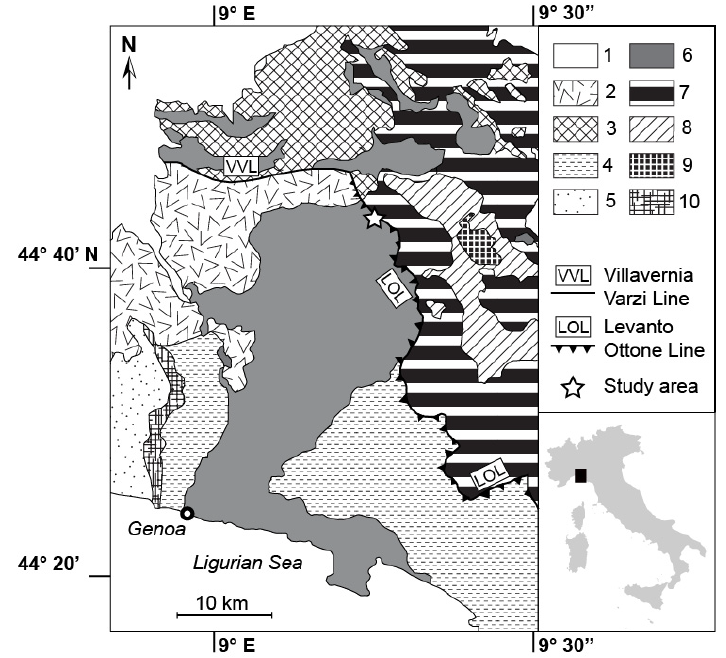
Figure 1. Tectonic sketch of North-Western Apennines: 1: Quaternary Deposits; 2: Tertiary Piedmont Basin deposits; 3: Epiligurian Succession; 4: Internal Ligurian Units; 5: Voltri Group; 6: Antola Unit; 7: External Ligurian Units; 8: Subligurian Units; 9: Tuscan Units (Tuscan Nappe); 10: Sestri-Voltaggio Zone.